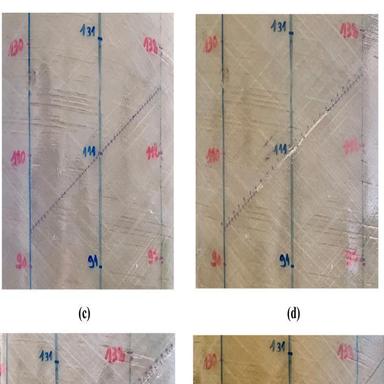
(a) Intact pipe, (b) Cracked pipe = 12 cm, (c) 40 cm, and (d) 60 cm.